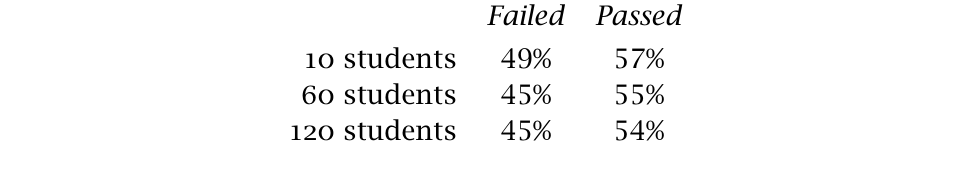
Mean answers by question and cardinality for questions (iii) and